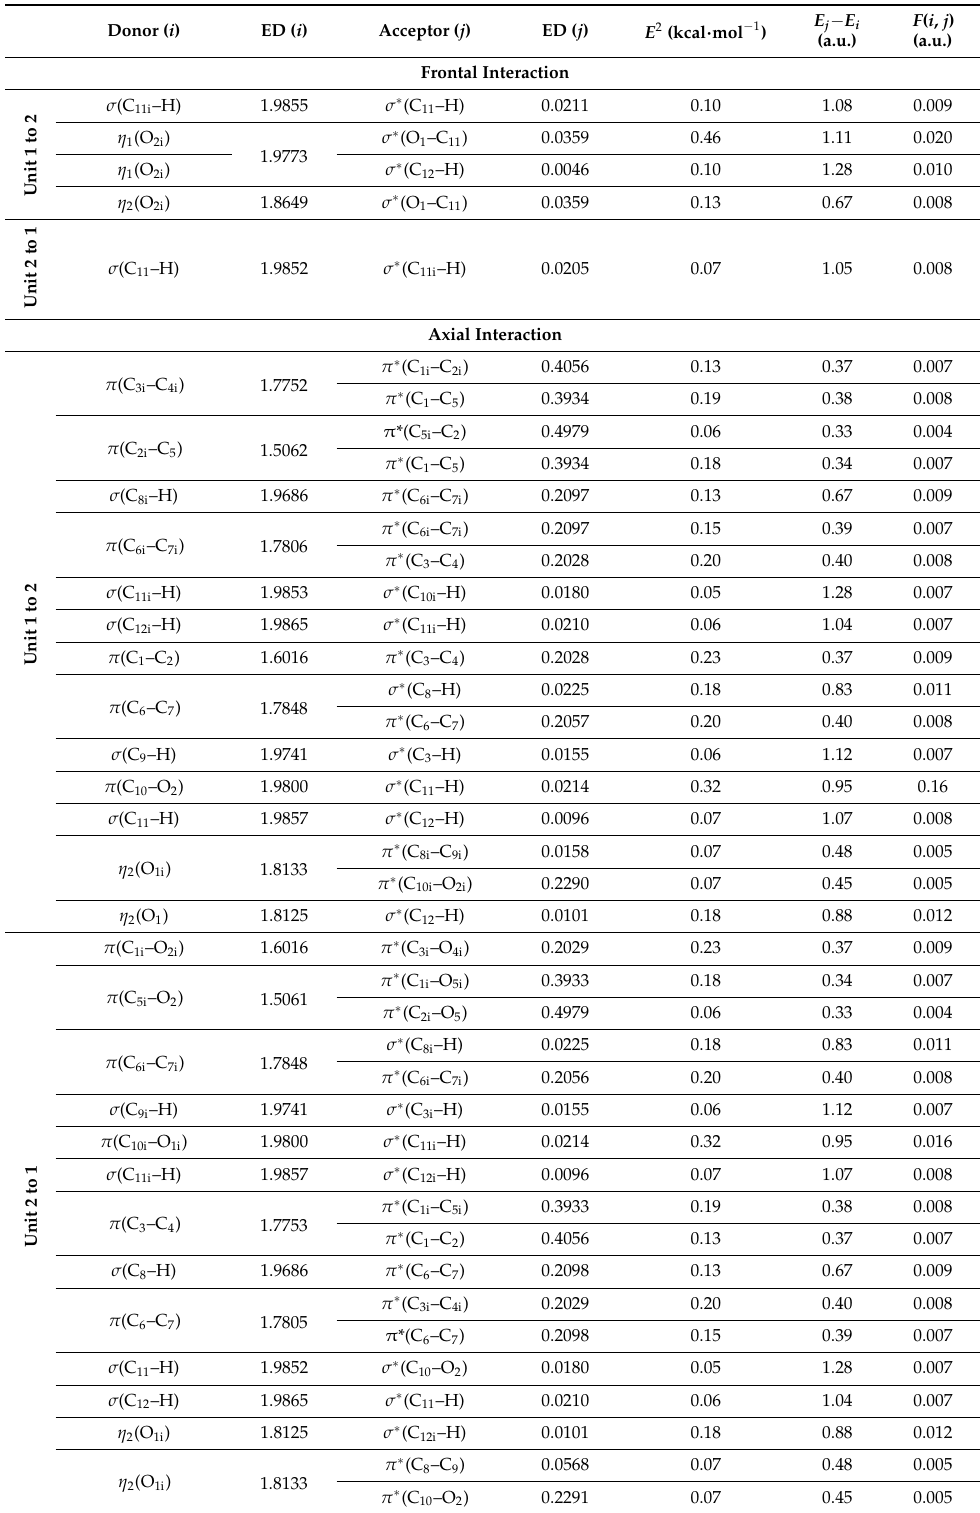
Table 3. Second-order perturbation theory analysis in NBO basis obtained at M06-2X/6-311G(d,p) level of theory for